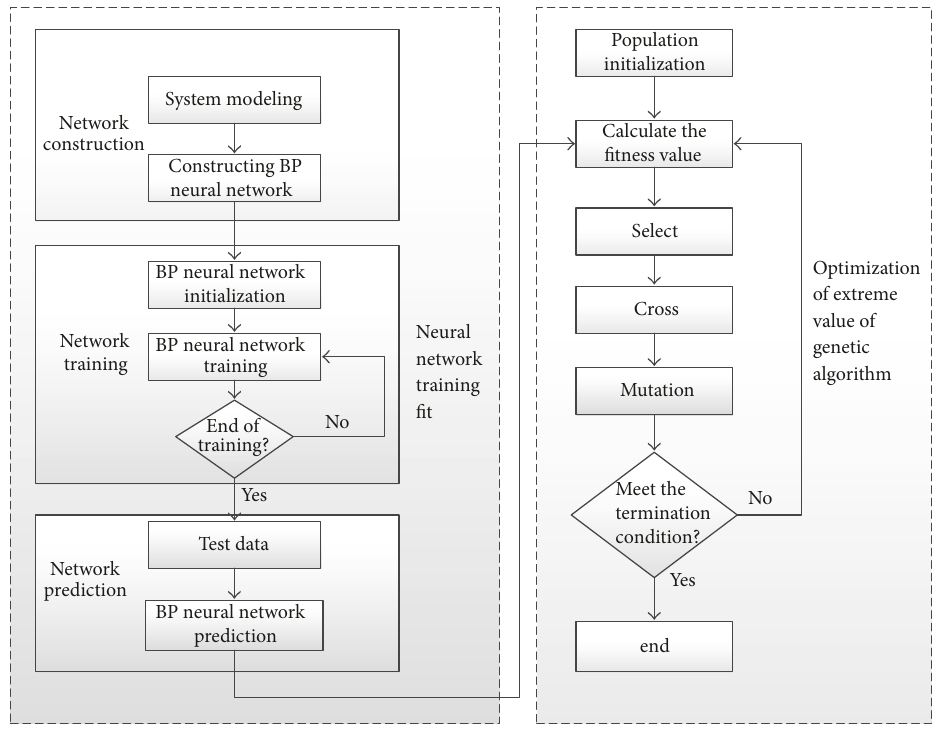
Figure 9: Neural network and genetic algorithm flow